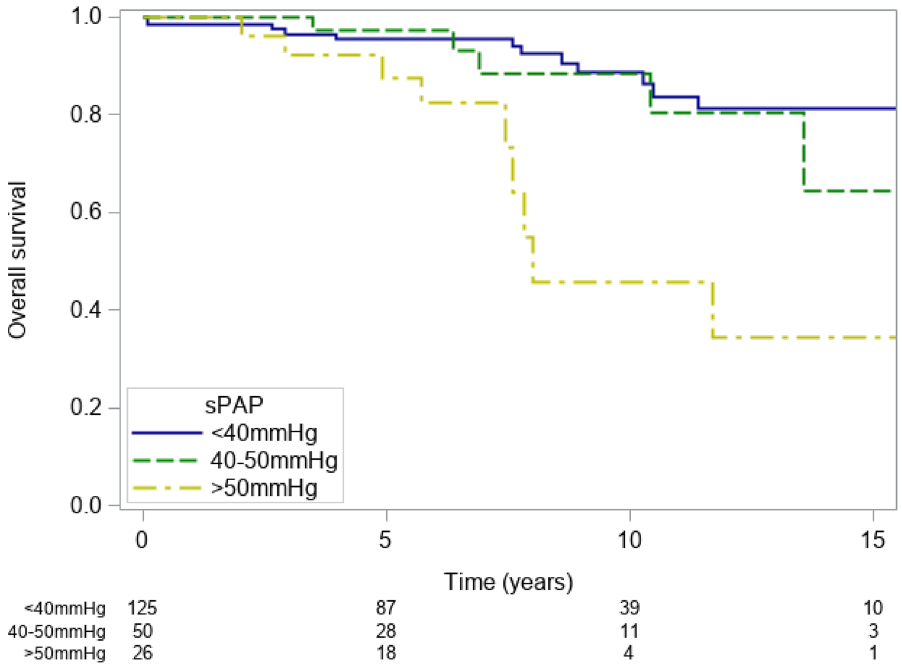
Figure 4. Kaplan–Meier overall survival estimates for patients with sPAP < 40 mmHg (blue line), 40–50 mmHg (green line) and > 50 mmHg (yellow line). sPAP systolic pulmonary artery